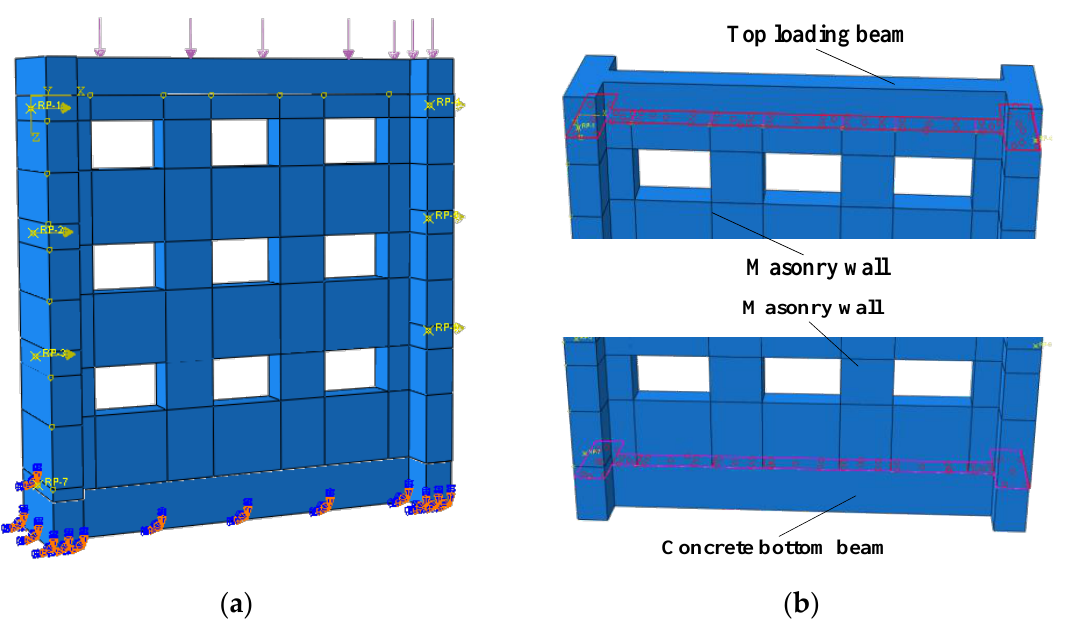
Figure 1. Finite element model: ( a ) loads and boundaries, ( b ) masonry-top-loading beam and masonry-concrete-bottom beam surfaces for the introduction of tie constraints.